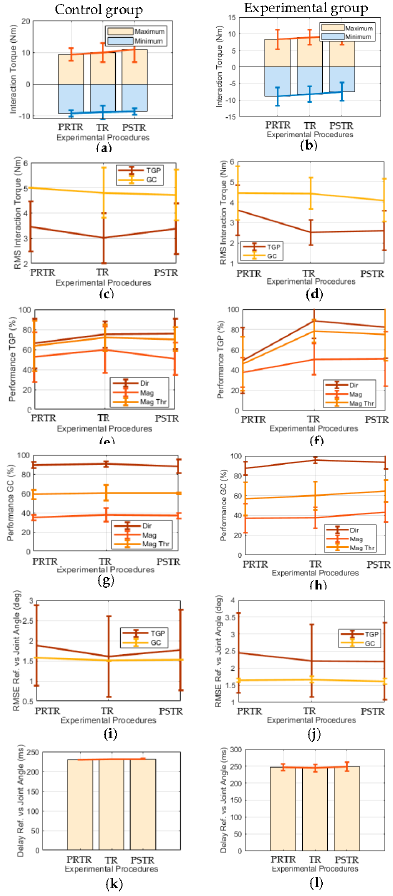
Figure 4. Mean and standard deviation per procedure (PRTR, TR, and PSTR) of ( a , b ) maximum and minimum human-robot interaction torque; ( c , d ) the RMS of the interaction torque for the training gait phase (TGP) and overall gait cycle (GC); Performance Dir, Mag, Mag Thr for ( e , f ) TGP and ( g , h ) GC; ( i , j ) the RMSE for TGP and GC; and ( k , l ) the delay between the reference joint angle ( Ref ) and real joint angle for the control / experimental group regarding the joint motion biofeedback